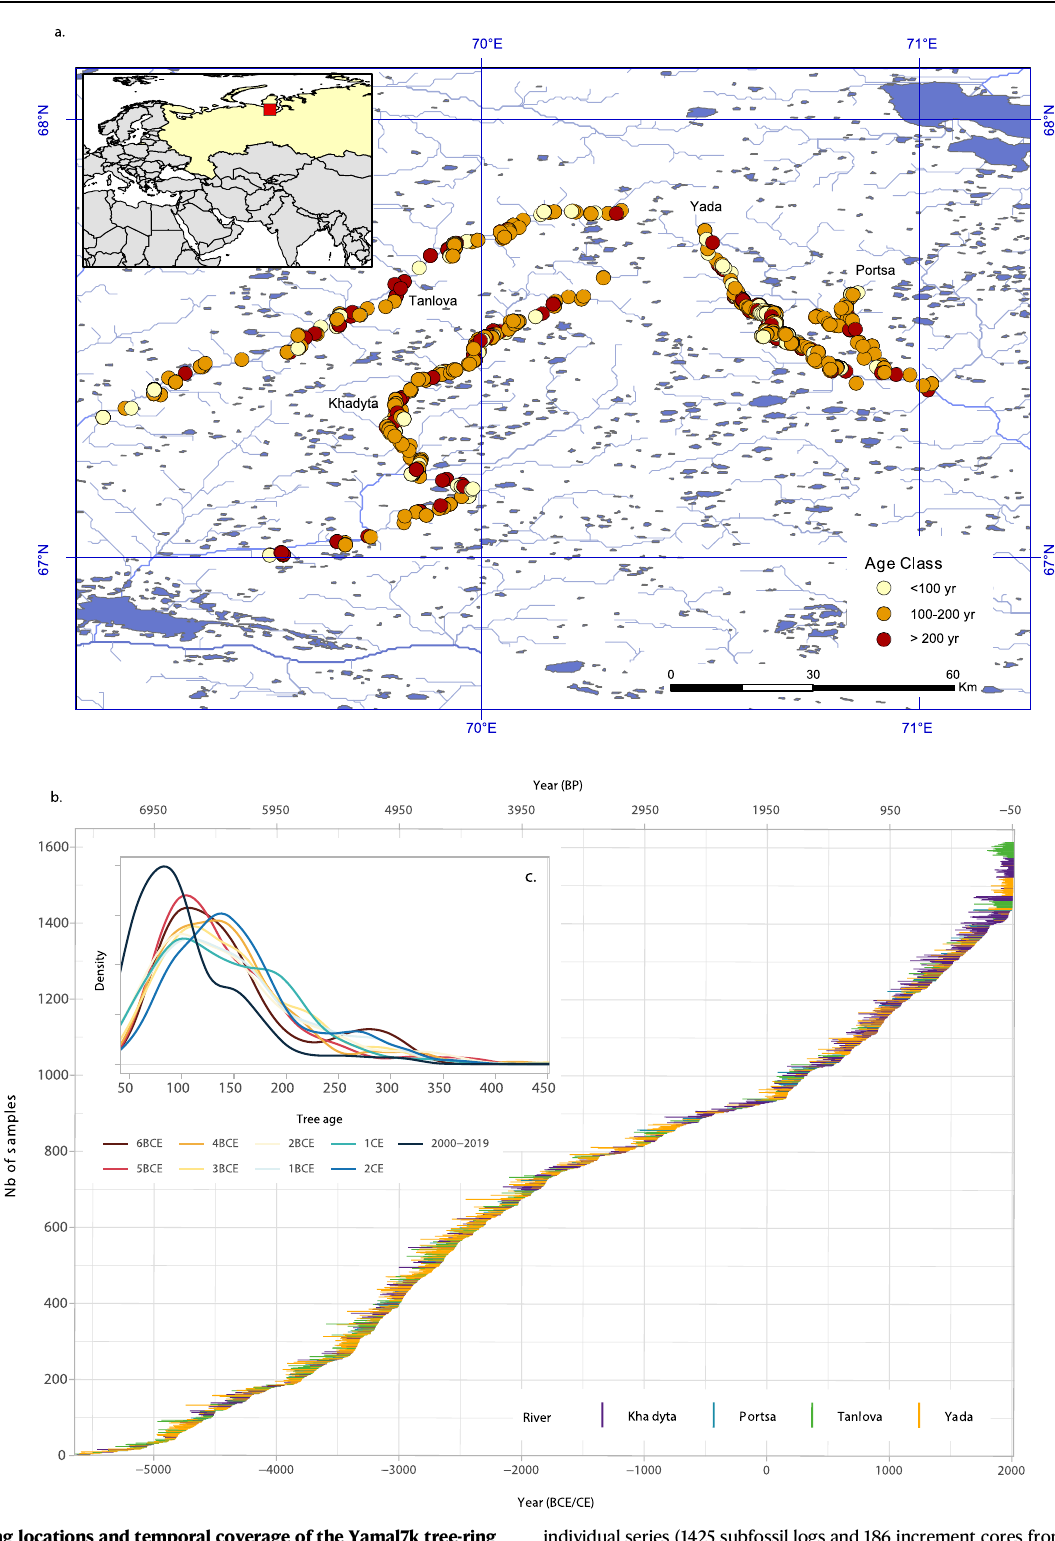
individual series (1425 subfossil logs and 186 increment cores from living trees) color coded by the corresponding river. The mean segment length is 142 years (ranging from 41 to 452). c Ring age distribution across